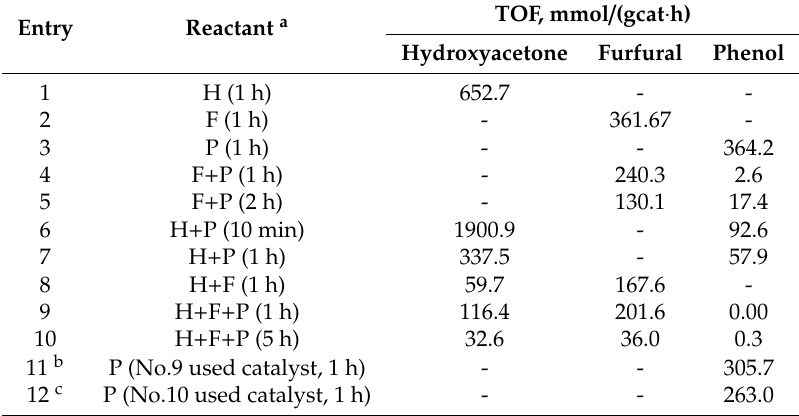
Table 3. Mixing conditions and corresponding TOF (turnover frequency) (180 ◦ C, 1 h, 3.5 Mpa H 2